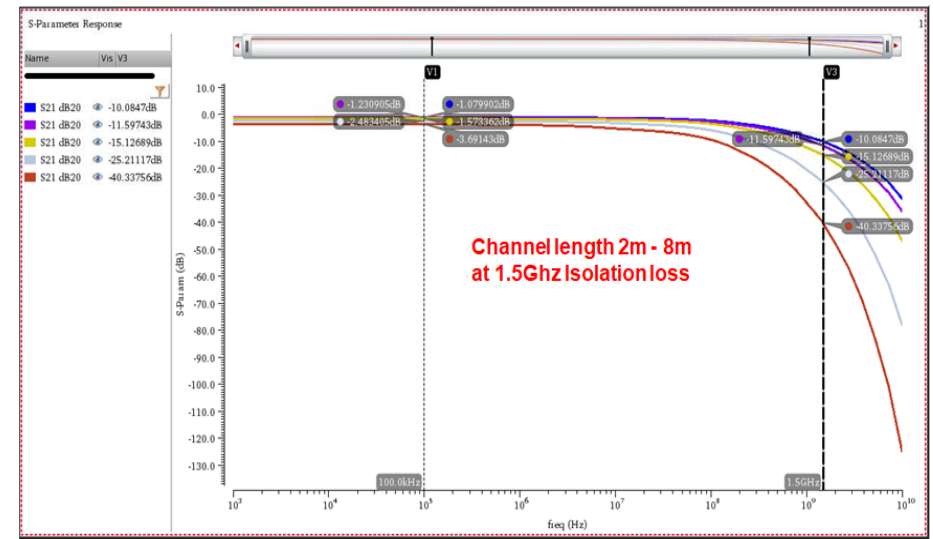
Figure 10. Variations in Channel Characteristics for Lengths of 2 m–8 m at 1.5 GHz.